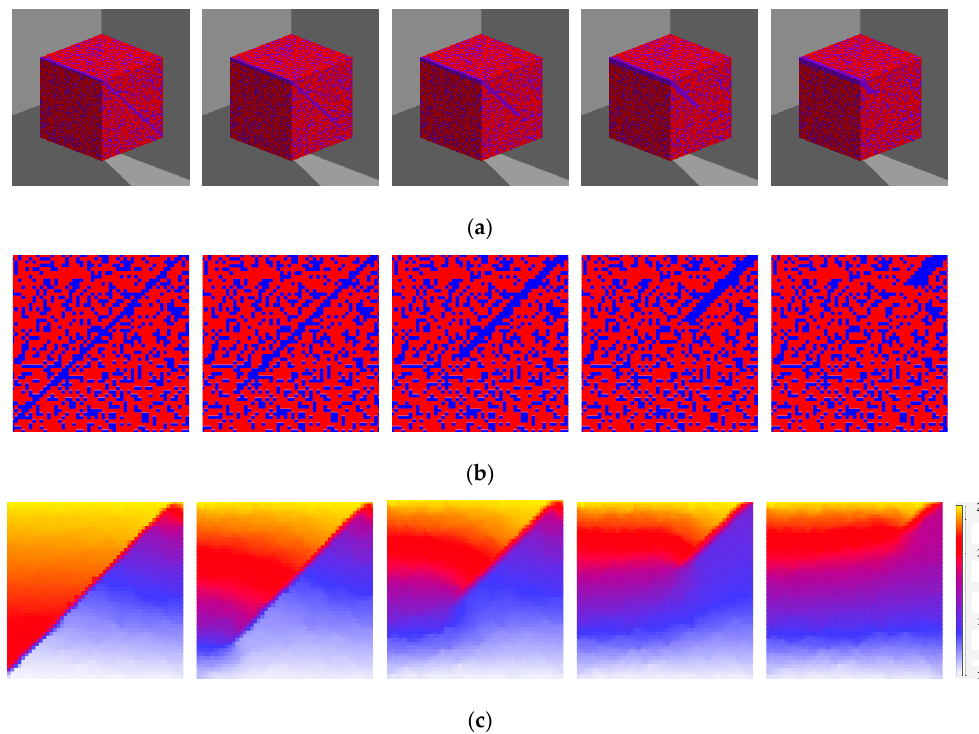
Figure 6. Digital rocks with tilted fractures (45 ◦ ): ( a ) digital rocks, ( b ) 2D slices, and ( c ) temperature distribution.